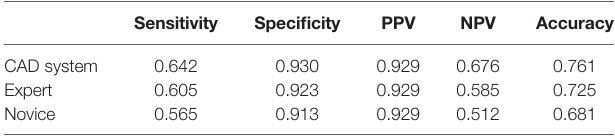
TABLE 1 | Diagnosis accuracy of CAD system, expert and novice in the